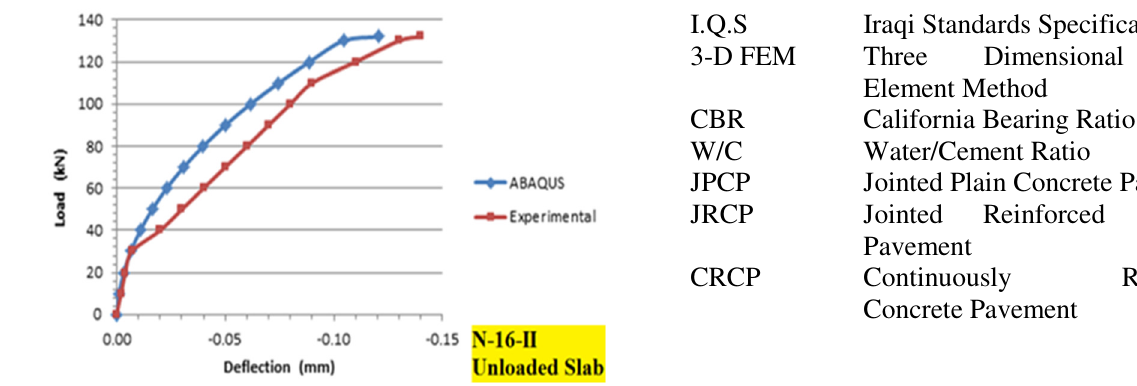
Fig. 16. The Behavior of Load-Deflection at Loaded and unloaded Sides for ABAQUS and Experimental